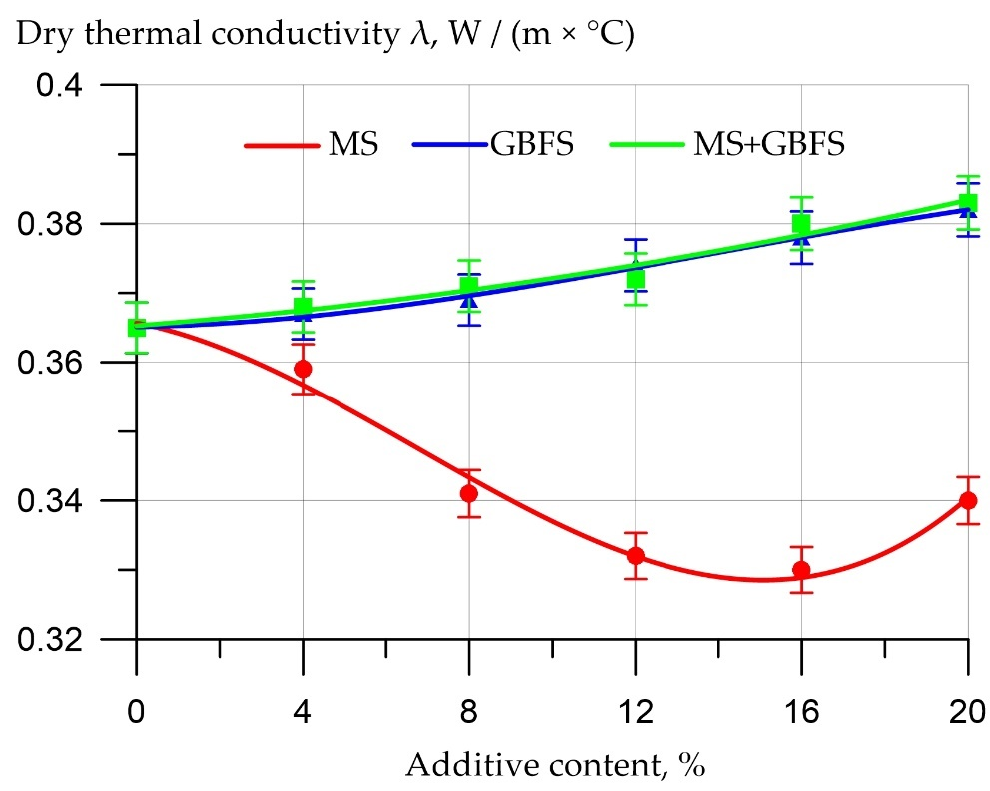
Figure 8. Change in the thermal conductivity of non-autoclaved aerated concrete depending on the percentage of binder replacement by various types of additives.